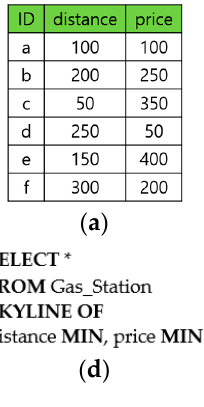
Figure 1. ( a ) Table Gas_Station; ( b ) attributes distance and price; ( c ) skyline points; and ( d ) skyline query in SQL.